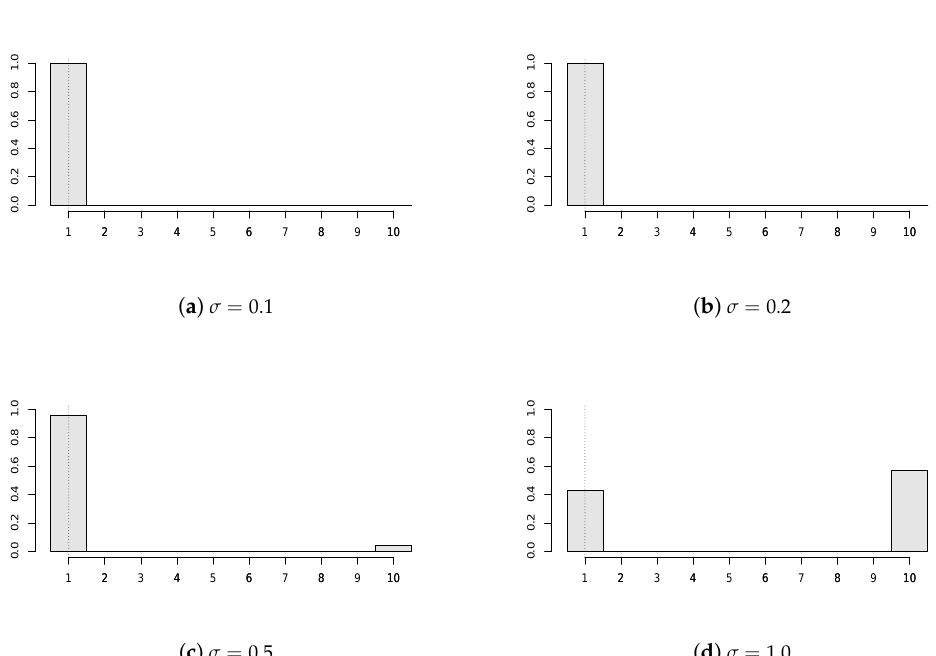
Figure 4. Histograms of the estimated change points (cid:98) τ N for various values of σ ( τ = 1, T = 10, N = 10, all of the panels are subject to a break of size δ i ∼ U [ 0,2 ] , panel disturbances from GARCH(1,1) with N ( 0,1 ) innovations).